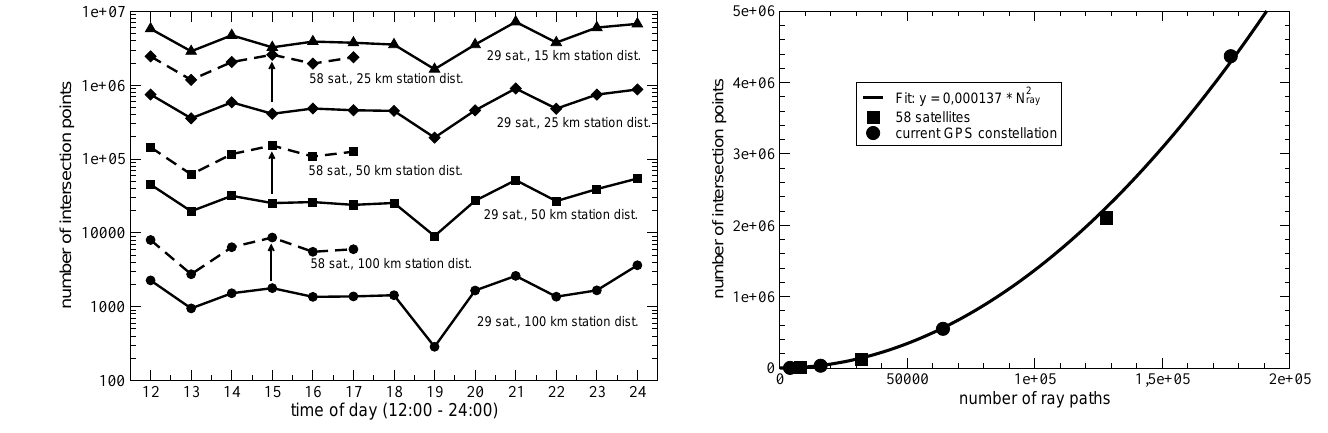
Fig. 3. Diurnal variation of intersection points for different den- sities of GPS ground stations. A realistic GPS constellation with 29 satellites has been computed for a 12h cycle (solid lines), a sit- uation with 58 satellites has been simulated for 6h (dashed lines). A 15 × 15 × 0 . 5km grid has been used to calculate the number of intersection points.